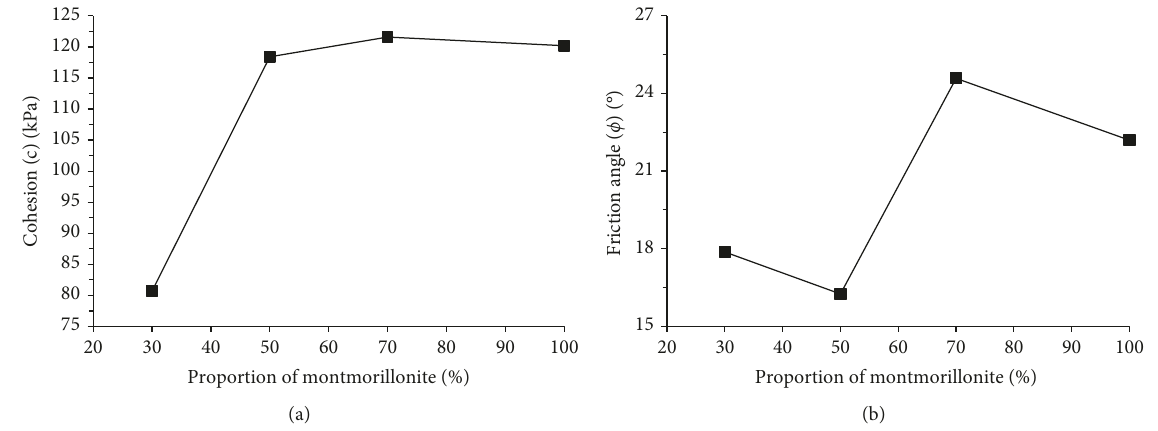
Figure 4: Variation of shear strength properties with clay proportion in the montmorillonite-quartz mixture: (a) cohesion and (b) frictional